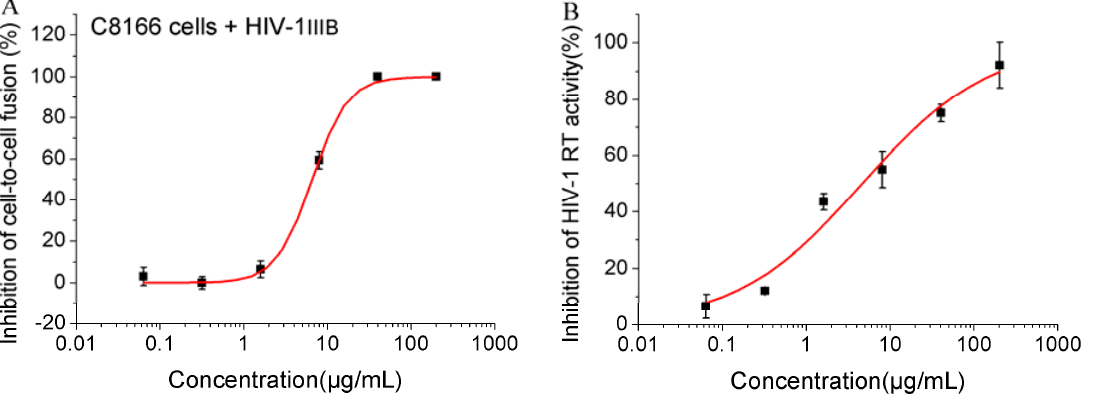
Figure 2. Inhibitory effects of YNS-PY-F on cell-to-cell fusion and RT activity. Inhibitory activity on the fusion of uninfected C8166 cells and H9 cells chronically infected HIV-1 was measured by syncytia reduction assay ( A ); Inhibitory activity on recombinant HIV-1 reverse transcriptase was measured by ELISA assay ( B ). The data shown in the figure are a representative of at least two independent